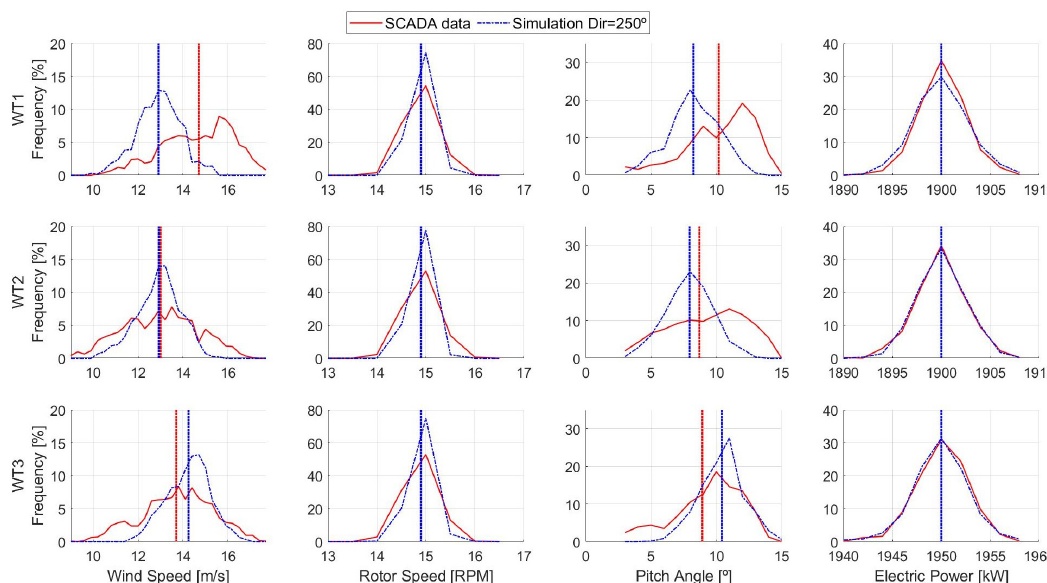
Figure 6. Histograms of wind speed (m/s), rotor angular speed (RPM), pitch angle ( ◦ ), and electric power (kW) from the SCADA data and simulation of wind turbines WT1, WT2, and WT3. Inflow condition of the simulation: Wind direction 250 ◦ (no wake interaction) and wind speed above rated. Vertical dashed lines represent the mean value of each